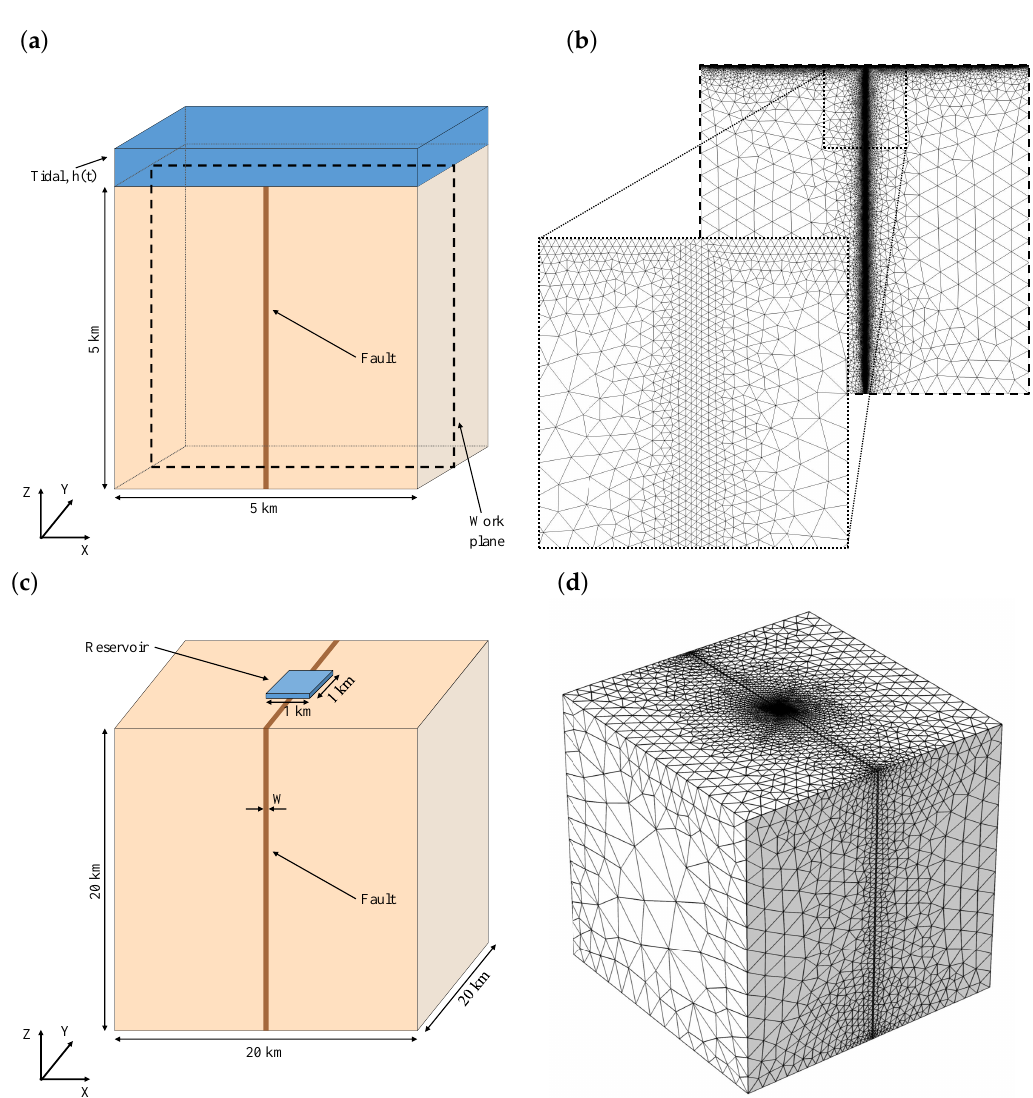
Figure 1. Sketch of the model geometry and computational meshes. We study the Coulomb Failure Function (CFF) changes in a vertical strike-slip fault with depth produced by both the tidal effects on a two-dimensional (2D) model (work plane on panel ( a )), and reservoir operation (panel ( c )). In the 2D case, the fault is embedded in a 5 km side square domain, while, in the three-dimensional (3D) one, it is embedded in a 20 km side cube. We model the fault as a rectangle with a certain width, softer and more permeable than the host rock matrix. The computational mesh of the 2D case is shown in panel ( b ) and the 3D case in panel ( d